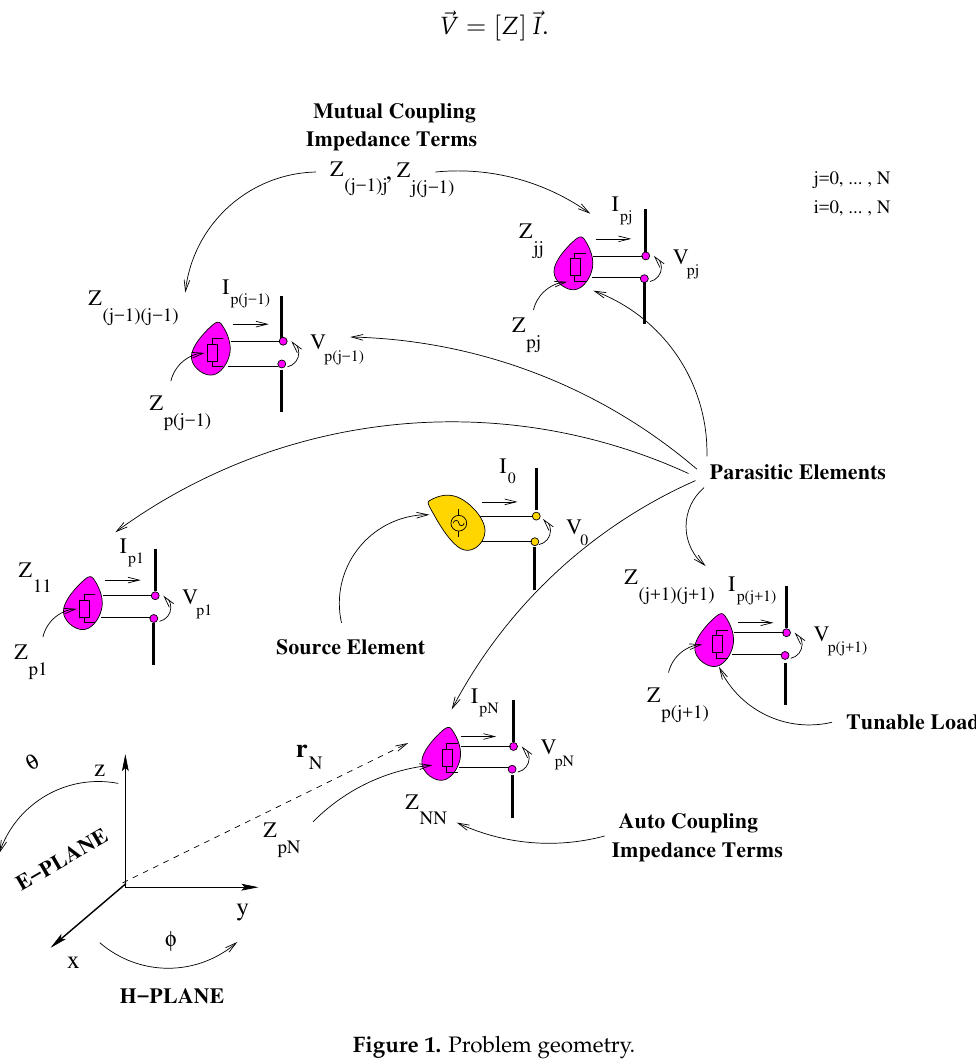
Figure 1. Problem